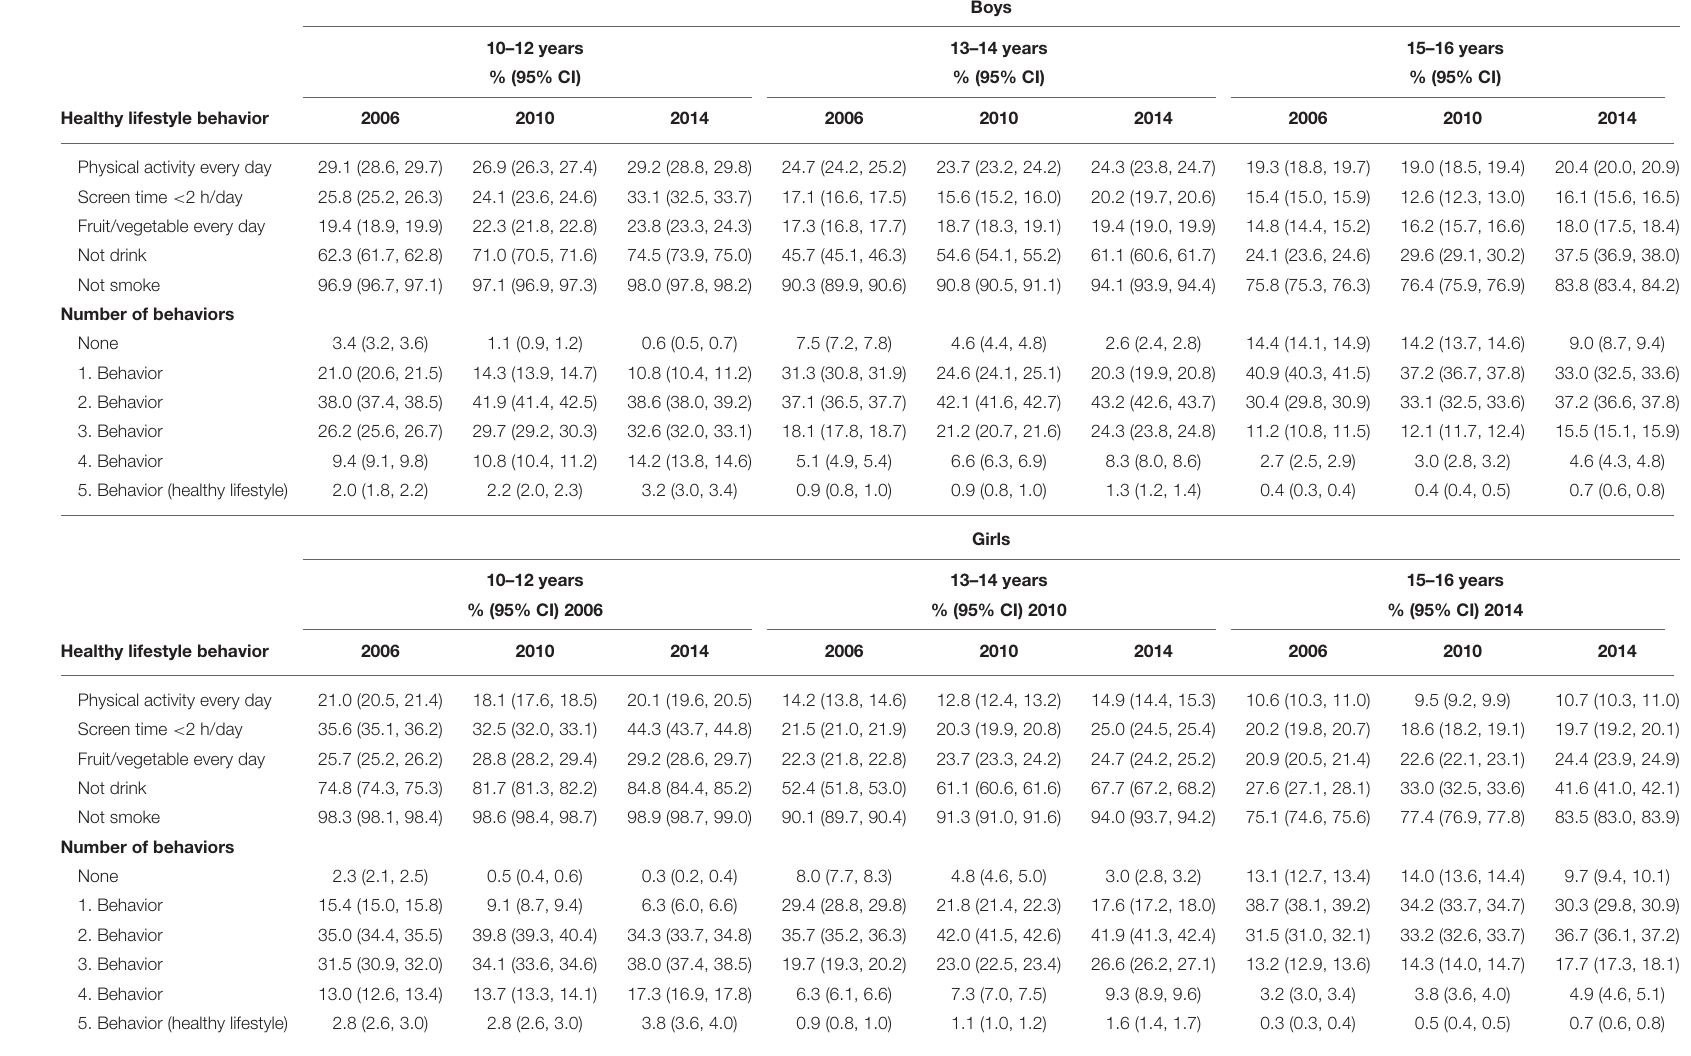
TABLE 2 | Healthy behaviors’ prevalence in 2006, 2010, and 2014 per sex and age